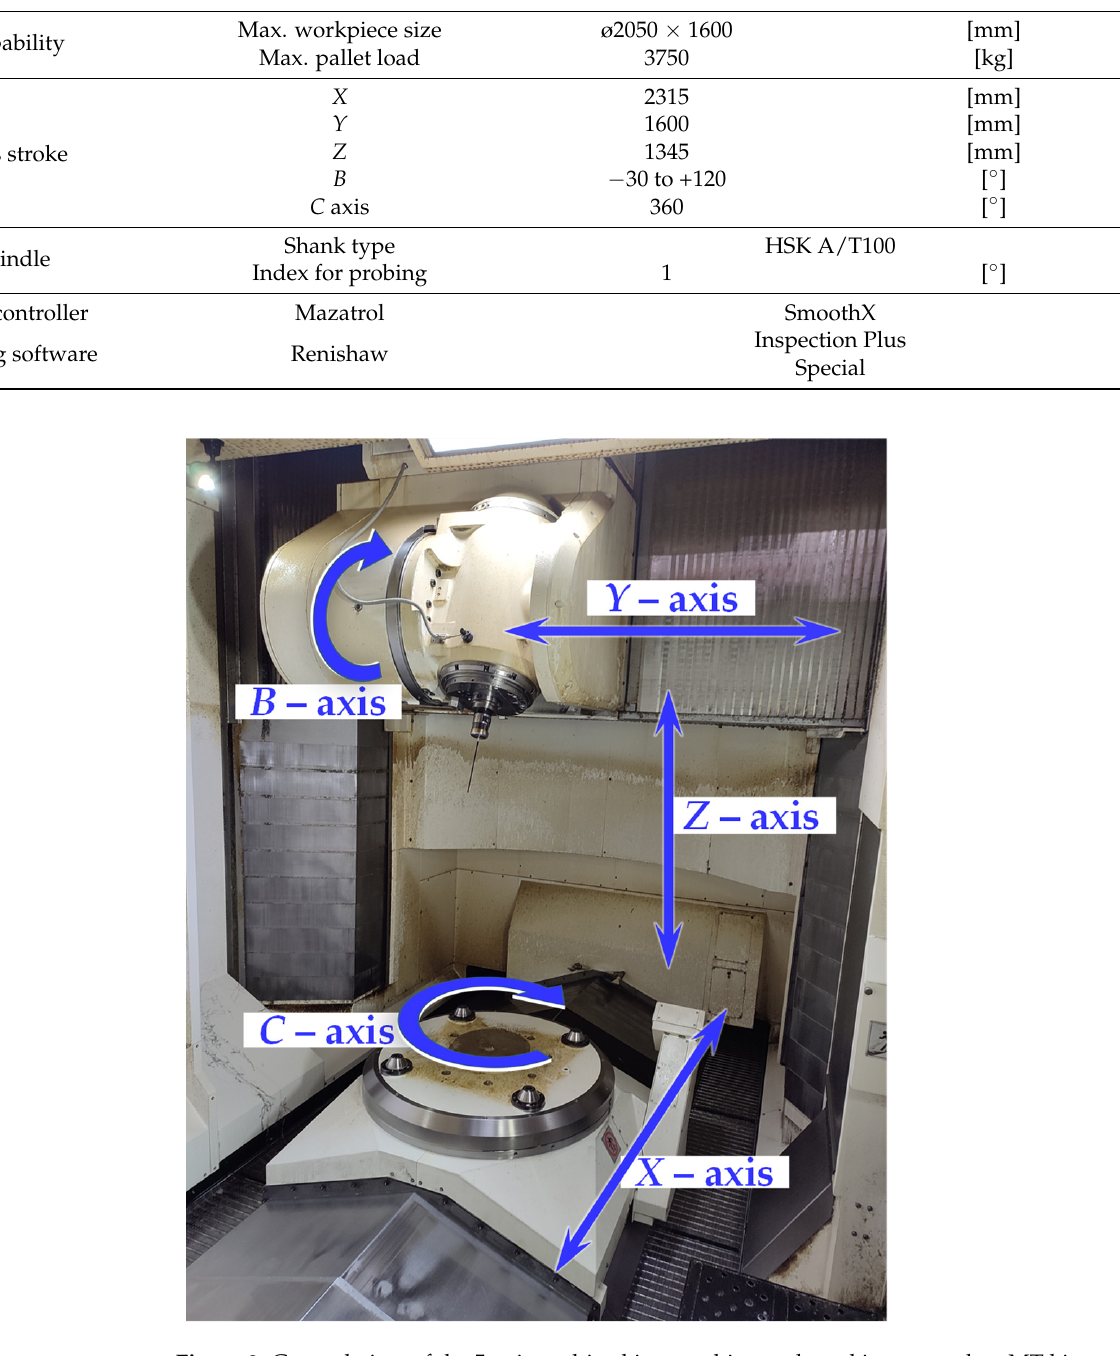
Figure 3. General view of the 5-axis multitasking machine tool used in our study—MT kinematics and axis structure view. Table 2. Touch-trigger probe configuration included in an advanced on-machine measurement system [34]. Application tags: S, setup; A, process adaptive; C, measurement; M, machine tool checkup and calibration.